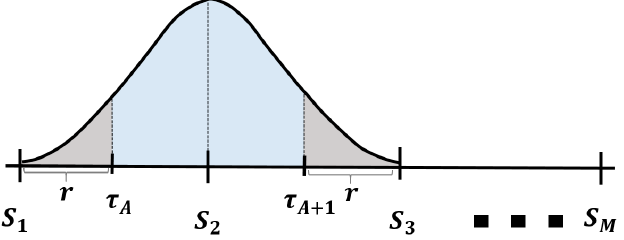
Figure 9. Distribution of the received signal over the resulted AWGN